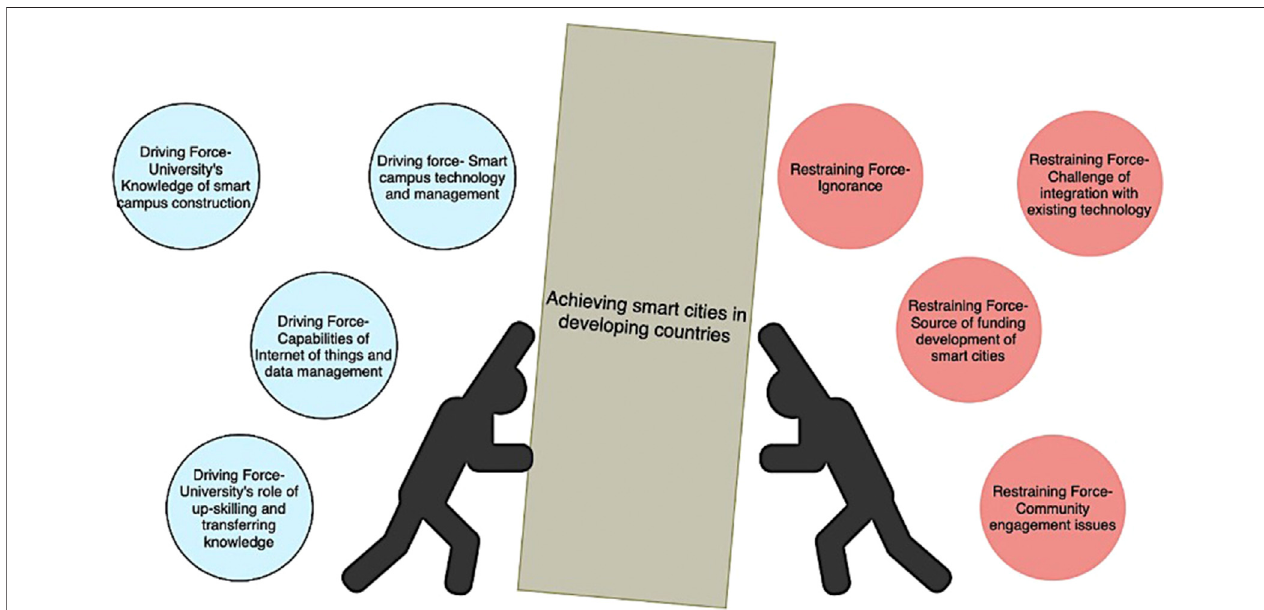
FIGURE 11 | Force fi eld of achieving smart cities in developing countries. Source: Authors.